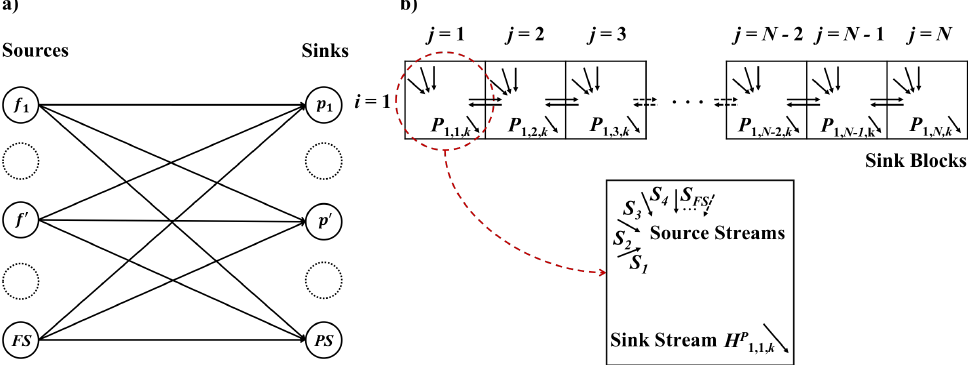
Figure 3. Block representation for fuel gas network problem: ( a ) Classical superstructure for fuel gas network; ( b ) Equivalent block superstructure for fuel gas